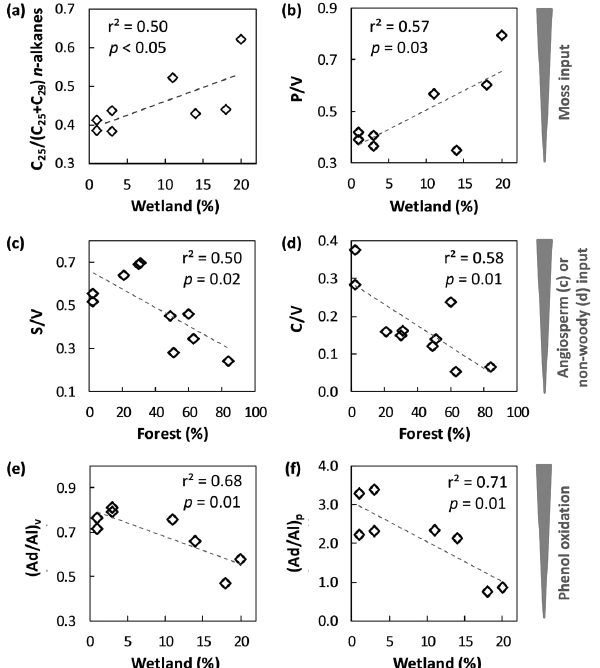
Figure 6. Influence of vegetation coverage on the OC source and degradation parameters in the Arctic watersheds. Panels (a) and (b) indicate more moss inputs at higher values. Panels (c) and (d) indicate more angiosperm and non-woody inputs, respectively, at higher values. Panels (e) and (f) indicate a more oxidized state of vanillyl and p -hydroxy phenols, respectively, at higher values. Re- fer to Table 3 for abbreviations and detailed values. Note that the Colville data are not included for the absence of information on its wetland coverage.